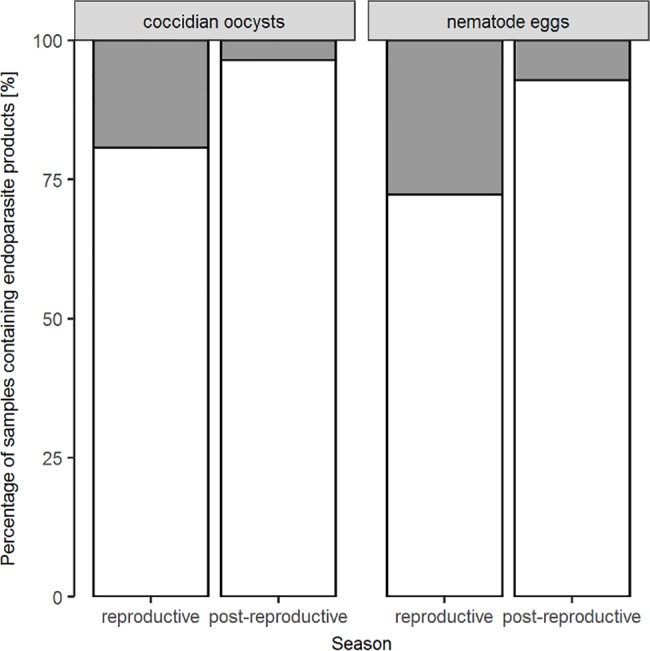
Seasonal differences in excretion patterns of endoparasite products.Percentage of samples containing (grey bars) as well as not containing (white bars) endoparasite products for the reproductive and post-reproductive season. Nreproductive = 83, Npost-reproductive = 28, Nsamples = 111.